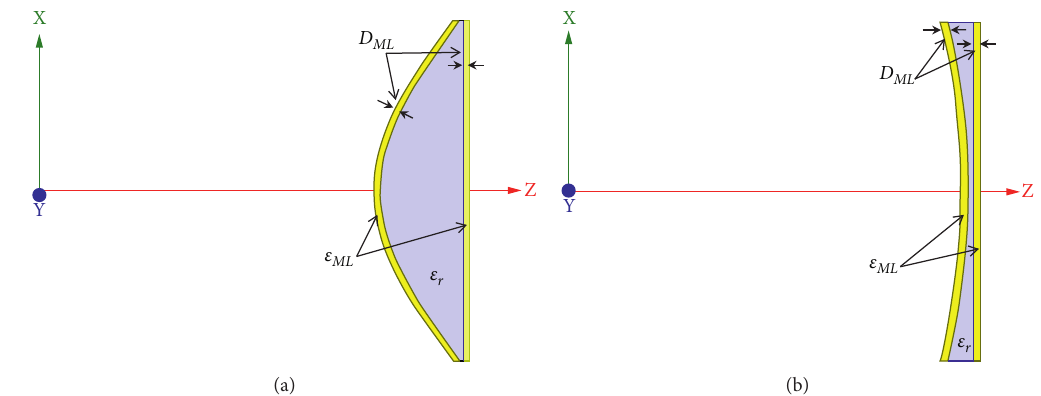
Figure 4: Lens structures with matching layers. (a) PRI lens with MLs. (b) NRI lens with MLs. Table 2: Simulation